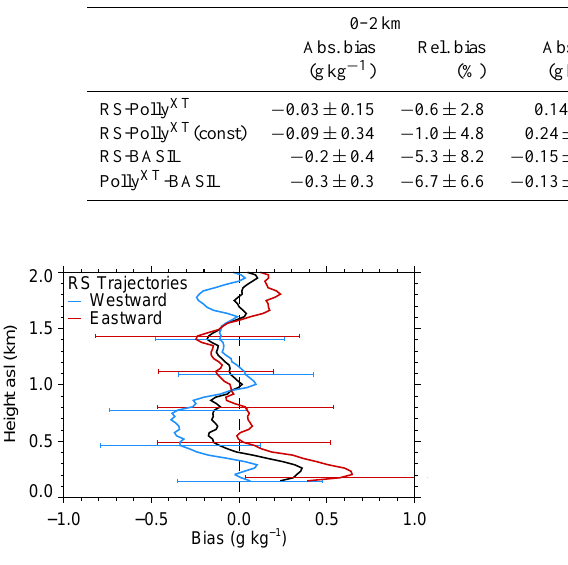
Brocard et al. (2013) found relative biases within 3 % up to 3 km during the day, and within 5 to 10 % up to 8 km dur- ing the night. Values of about 0 . 6 ± 0 . 6 gkg − 1 in the altitude range 1.5 to 5.5 km were identified by Navas-Guzmán et al. (2014).